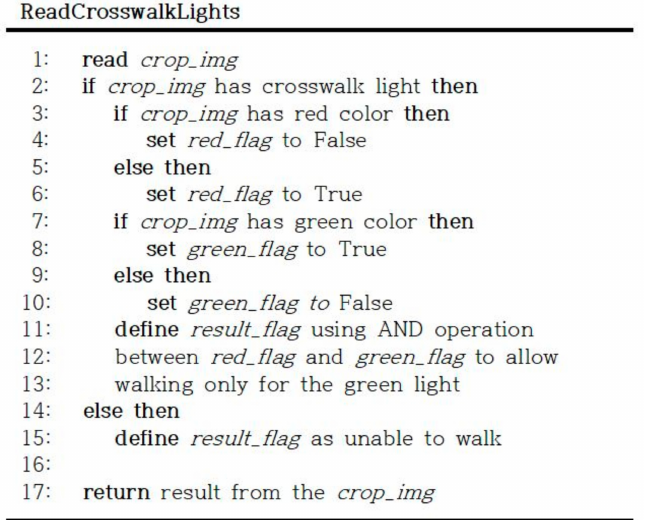
Figure 2. Algorithm for crosswalk discrimination (color identification).